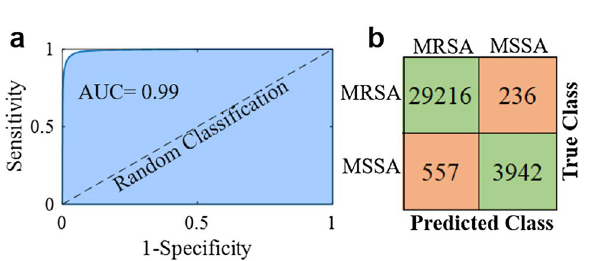
Figure 5. Binary classification results of MRSA and MSSA by the SAE based deep learning model. ( a ) The ROC curve with an AUC of 0.99. ( b ) Confusion matrix showing the results of ten-fold cross validated bacterial identification.